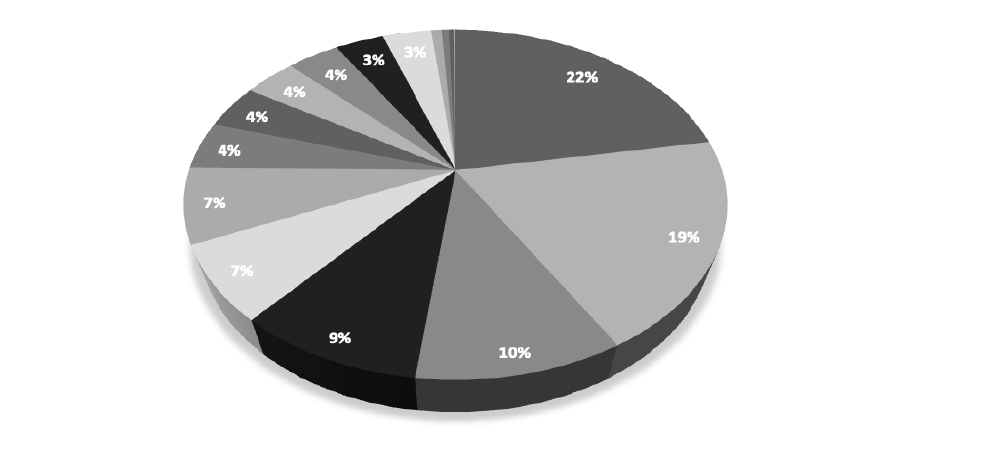
Figure 2. Percentage of the number of records entered into the database by bariatric centers. Legend: Each color on the chart corresponds to a different bariatric center which entered records into the database. The numbers on the chart indicate the percentage contribution of the number of records entered by the bariatric center compared to all records in the database.